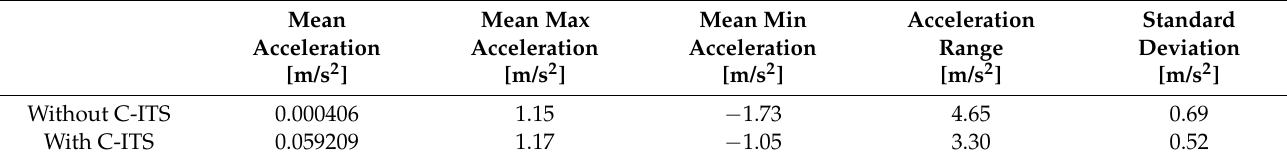
Figure 9. Box plot of acceleration for all tested vehicles.